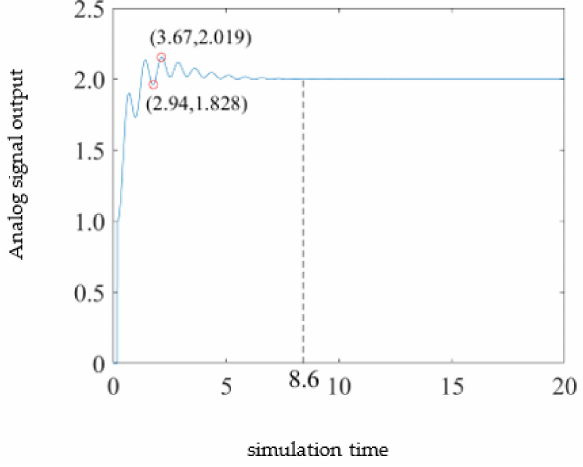
Figure 10. Simulation waveform of PID control